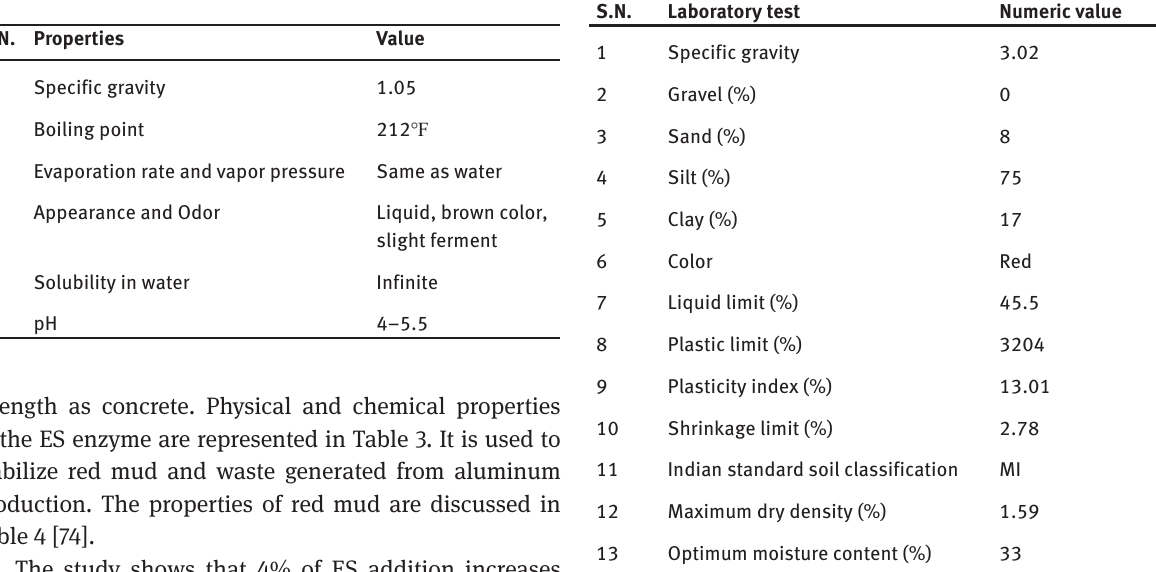
Table 4: Geotechnical property of red mud